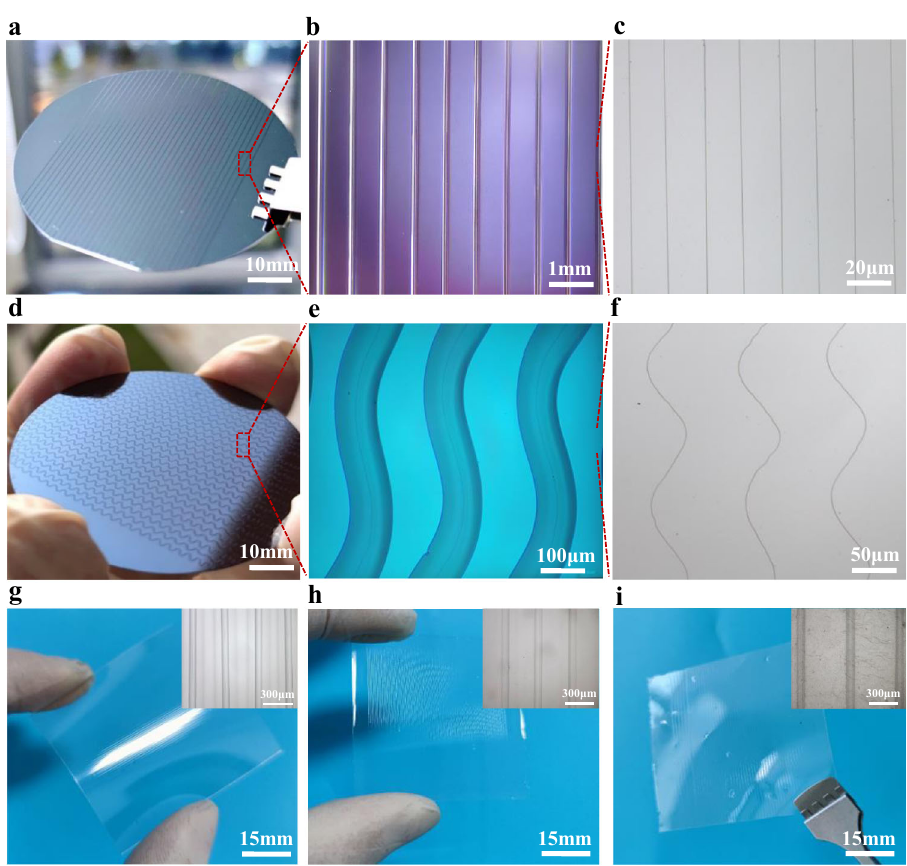
Fig. 2 | Images of PDVT-10 structures fabricated by CFEJ printing and sub- microwire arrays on different substrates. a – c Linear array structures printed on silicon wafer. d – f Sinuous structures printed on silicon wafer. g Linear array structures printed on PET fl exible substrate, where the substrate thickness is